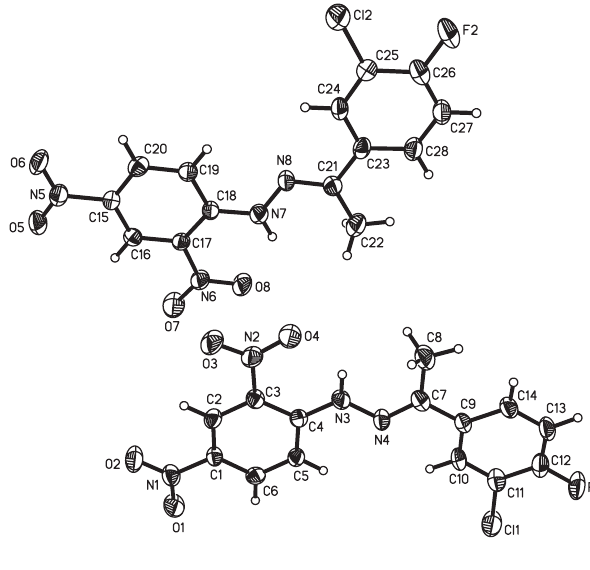
Table 1: Data collection and